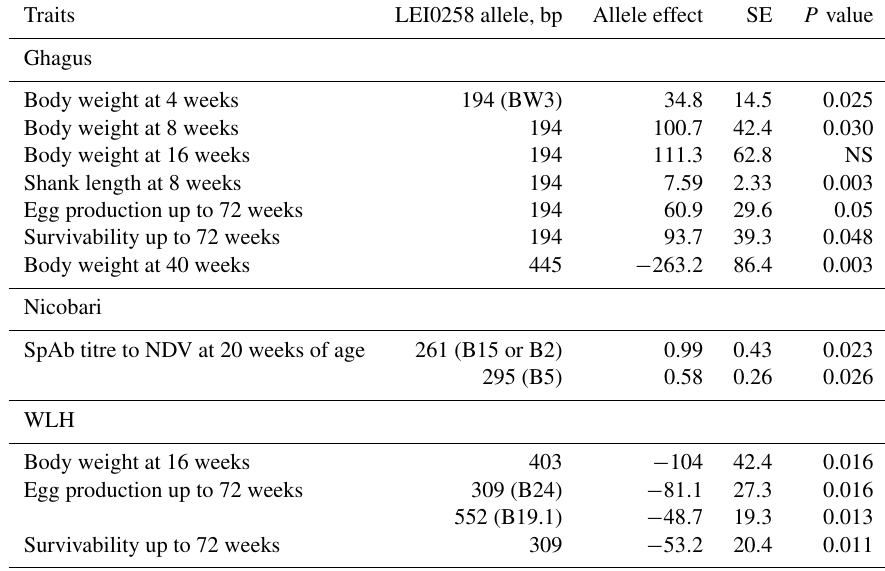
Table 5. Association of LEI0258 alleles with survivability, production and antibody traits in indigenous and WLH breeds of chicken. Traits LEI0258 allele,